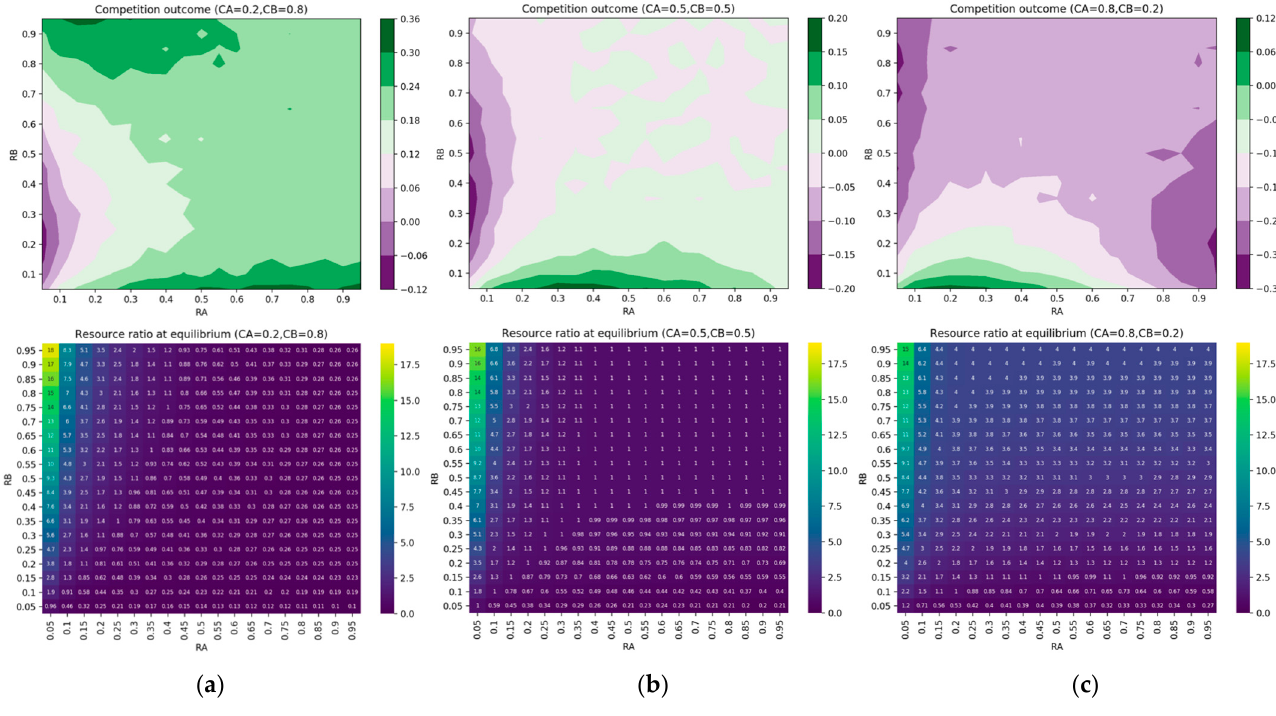
Figure 4. Average competition outcomes and average RREs of 1000 simulations under different budgets and different pairs of unit costs: ( a ) C A = 0.2, C B = 0.8; ( b ) C A = 0.5, C B = 0.5; and ( c ) C A = 0.8, C B =